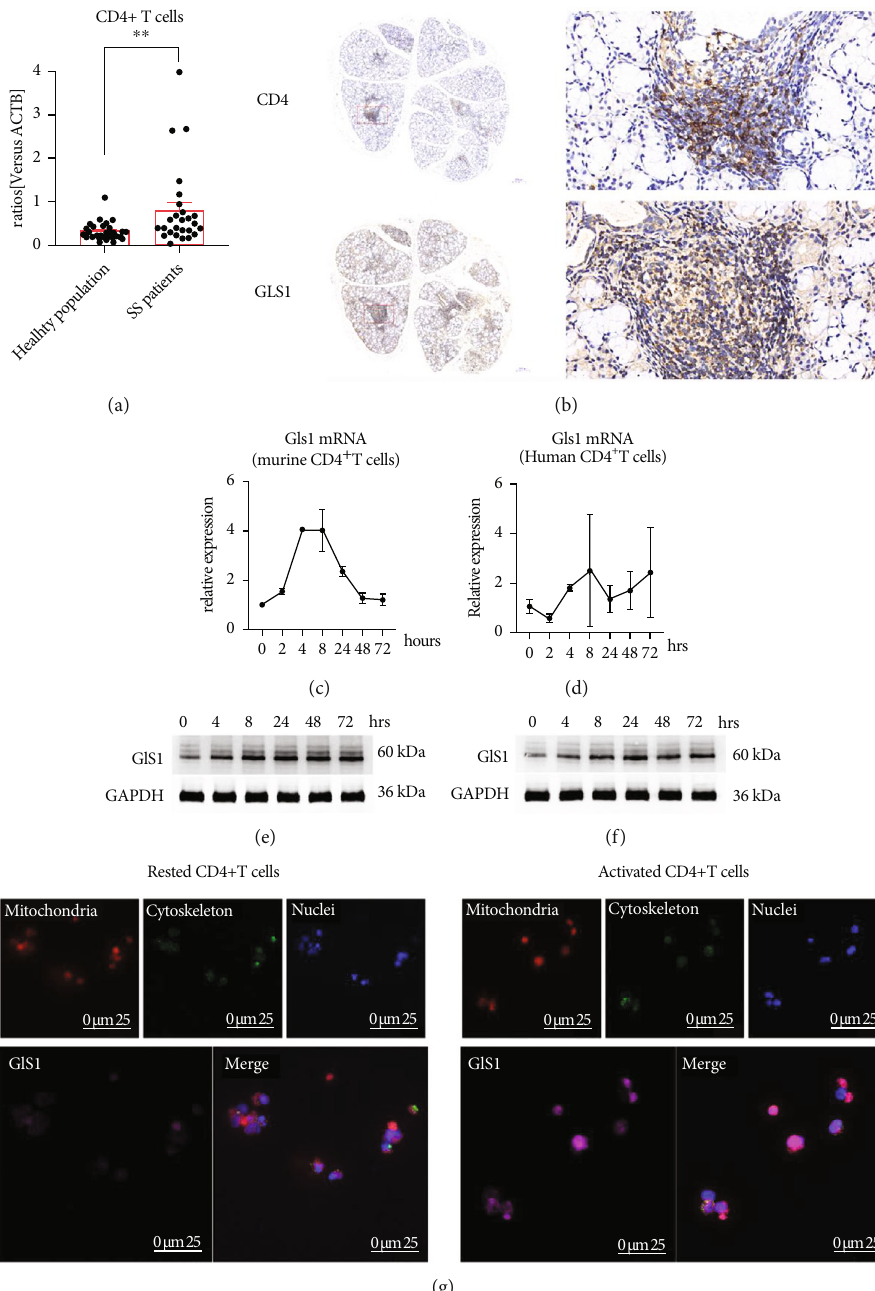
Figure 1: Gls1 was upregulated in SS patients and could be induced upon activation. (a) Expression of Gls1 in circulating CD4+ T cells obtained from healthy individuals and SS patients. n > 25 . (b) Immunohistochemical staining of CD4-positive cells and Gls1-positive cells in the labial glands of SS patients. (c) qRT – PCR analysis of Gls1 mRNA expression in murine CD4+ T cells simulated with anti- CD3 and anti-CD28 antibodies in a time-dependent manner. (d) qRT – PCR analysis of Gls1 mRNA expression in human puri fi ed circulating CD4+ T cells simulated with anti-CD3 and anti-CD28 antibodies in a time-dependent manner. (e) Representative Western blot pictures of Gls1 protein expression in human puri fi ed circulating CD4+ T cells simulated with anti-CD3 and anti-CD28 antibodies. (f) Representative Western blot pictures of Gls1 protein expression in murine splenic CD4+ T cells simulated with anti-CD3 and anti- CD28 antibodies. (g) Representative picture of Gls1 expression and location in murine CD4+ T cells under a confocal microscope. Blue light indicates the position of nuclei; green light indicates the position of the cytoskeleton; red light indicates the position of mitochondria; violet light indicates the position and strength of Gls1. Summary data are presented as ∗∗ p < 0 : 001 with unpaired two- tailed Student ’ s t